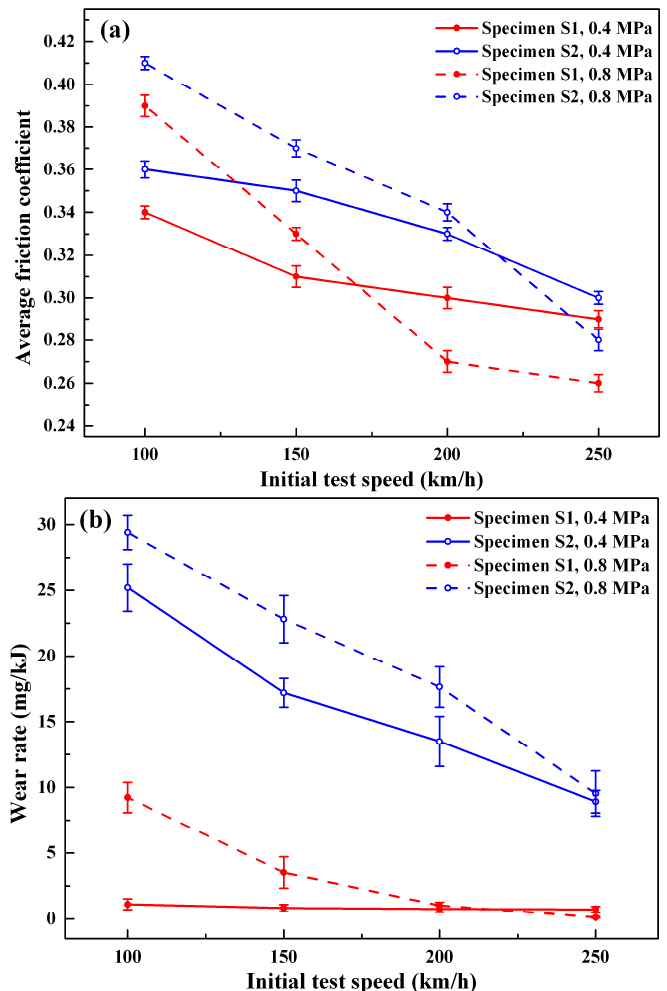
Figure 6. Average friction coefficient ( a ) and wear rate ( b ) under different conditions.